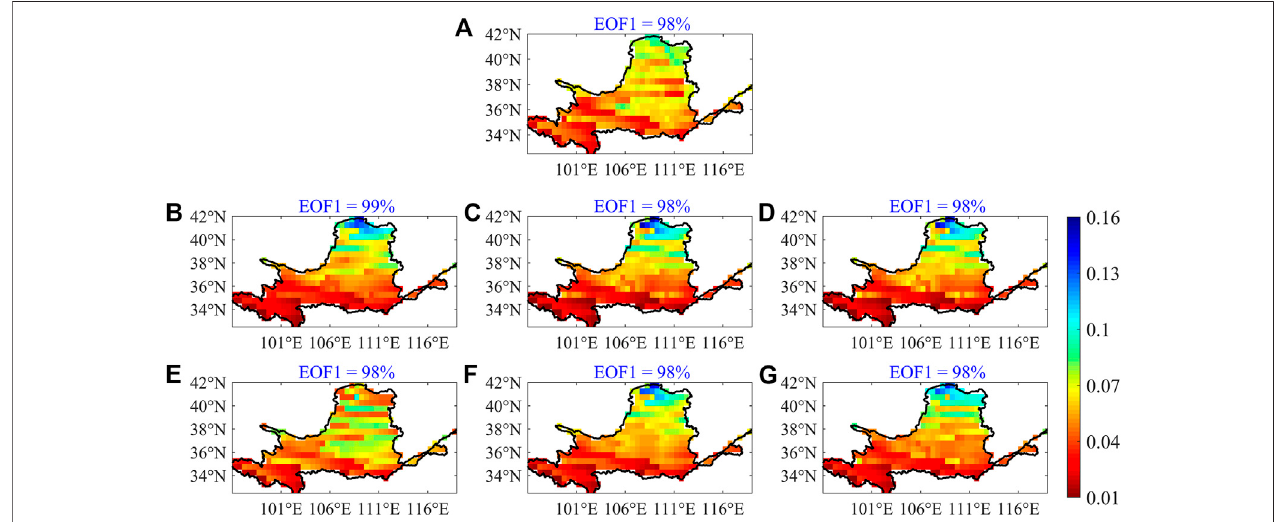
FIGURE11| Spatial distribution ofthesecondEOFmode (EOF2)oftheaverageannualprecipitationfromobservation andsixhigher-scoring GCMs.Panels (A – G) are the observed data, ACCESS-CM2, CNRM-CM6 -1, CNRM-ESM2-1, FGOALS-f3-L, MPI-ESM1-2-HR, MRI-ESM2-0.